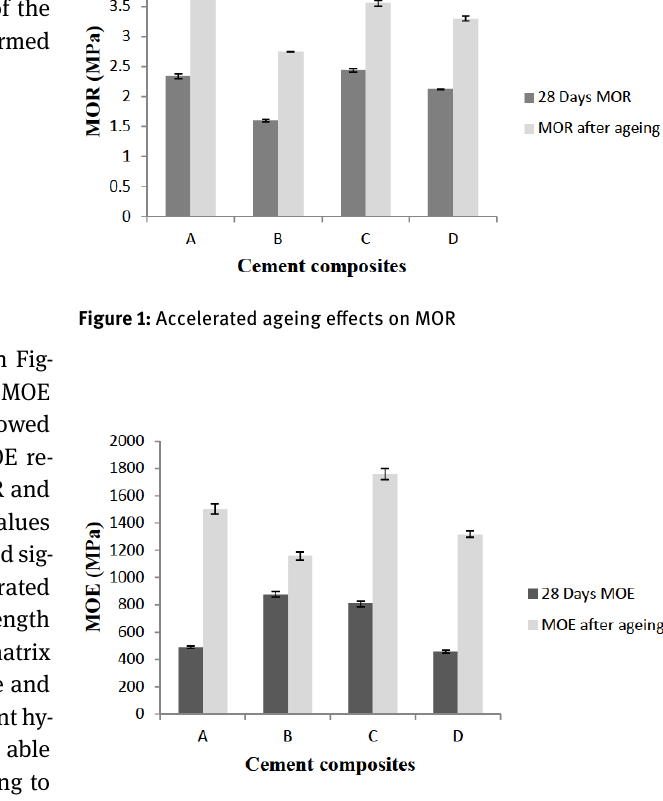
Figure 2: Accelerated ageing effects on